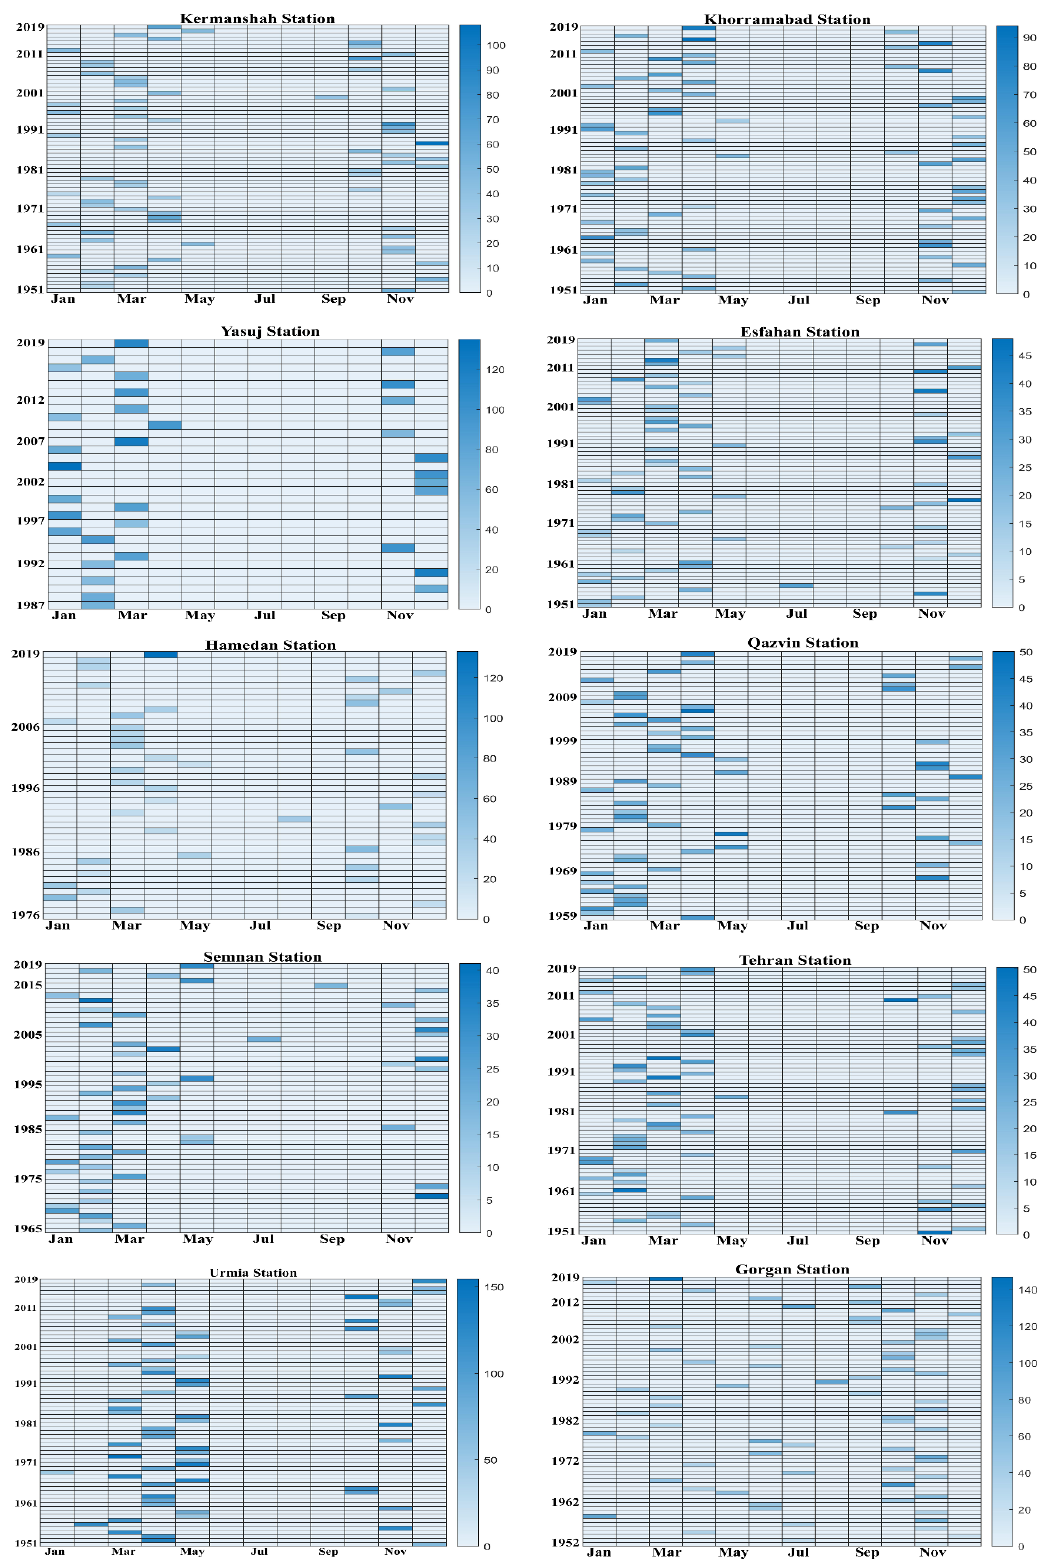
Figure 4. Heat map of the timing and depth of the annual maximum daily